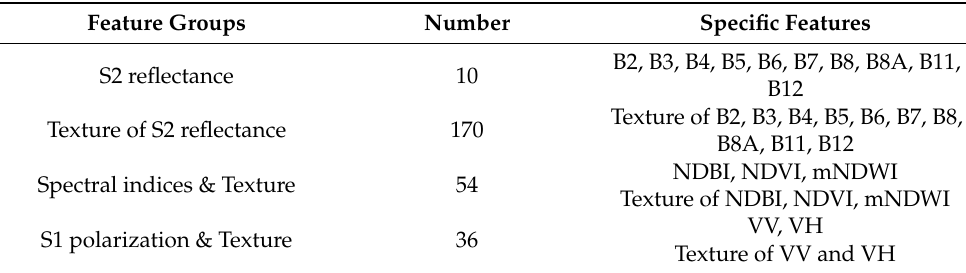
Table 3. All 270 features under assessment in this